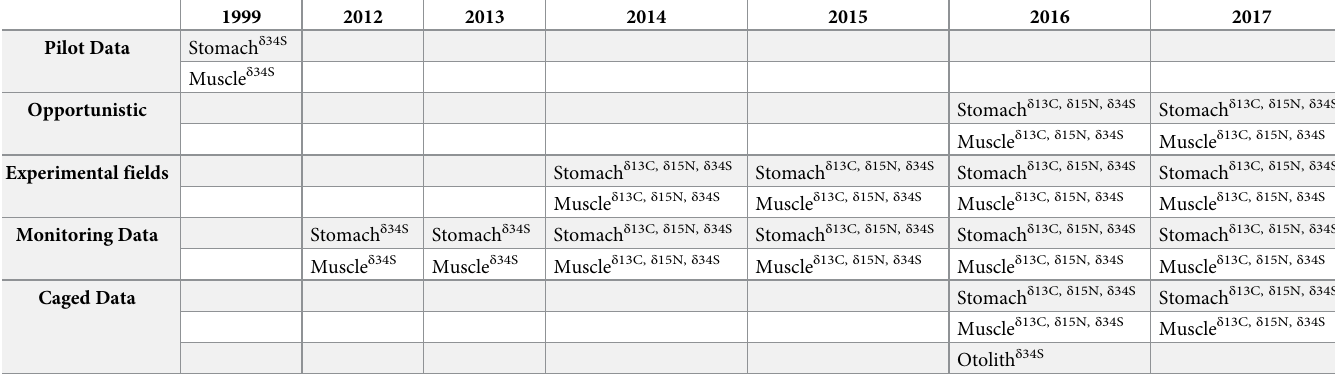
Table 1. Chronology of data collection with the tissue types and isotope systems